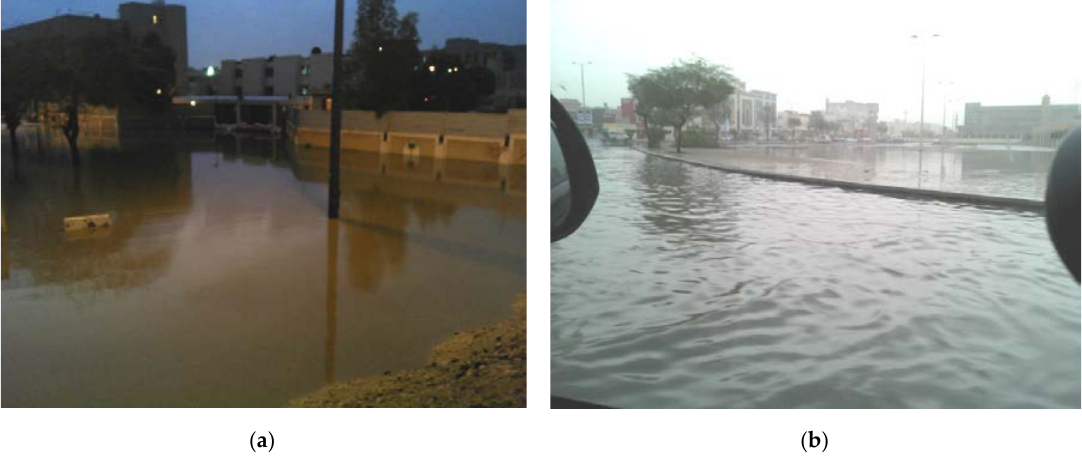
Figure 5. Photographs showing flooding in the city of Buraydah, ( a ) flood around King Fahd Hospital; ( b ) flooding on King Abdullah Road at its intersection with Ali Bin Abi Taleb